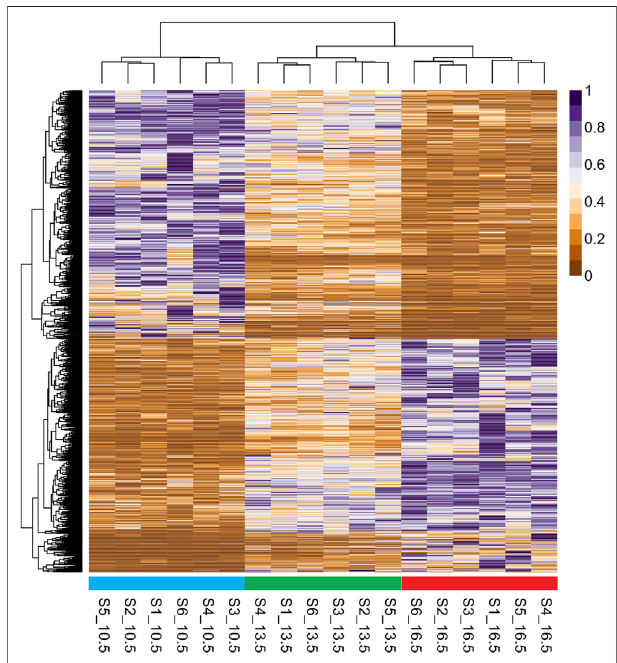
FIGURE 2 | Heatmap and hierarchical clustering of differentially expressed transcripts (1759 DETs) found in comparison of all three rearing temperature treatments. RNA samples used in sequencing are labeled on the baseofthe fi gure,withstandardizedfragmentsperkilobaseoftranscript per million mapped reads (FPKM) values for each DET clustered along the vertical